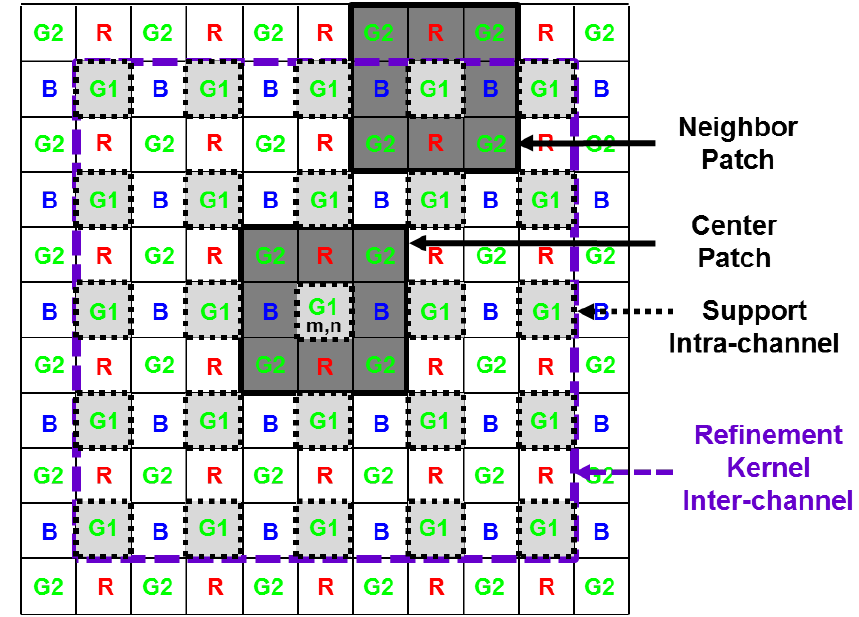
Figure 4. Boundaries used in the proposed method.